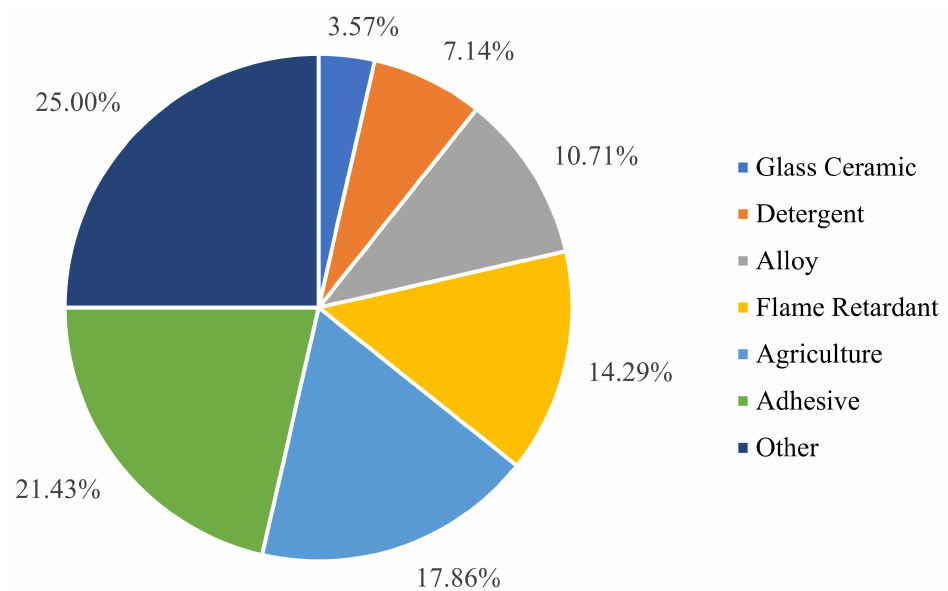
Figure 3. The proportion of boron consumption in various